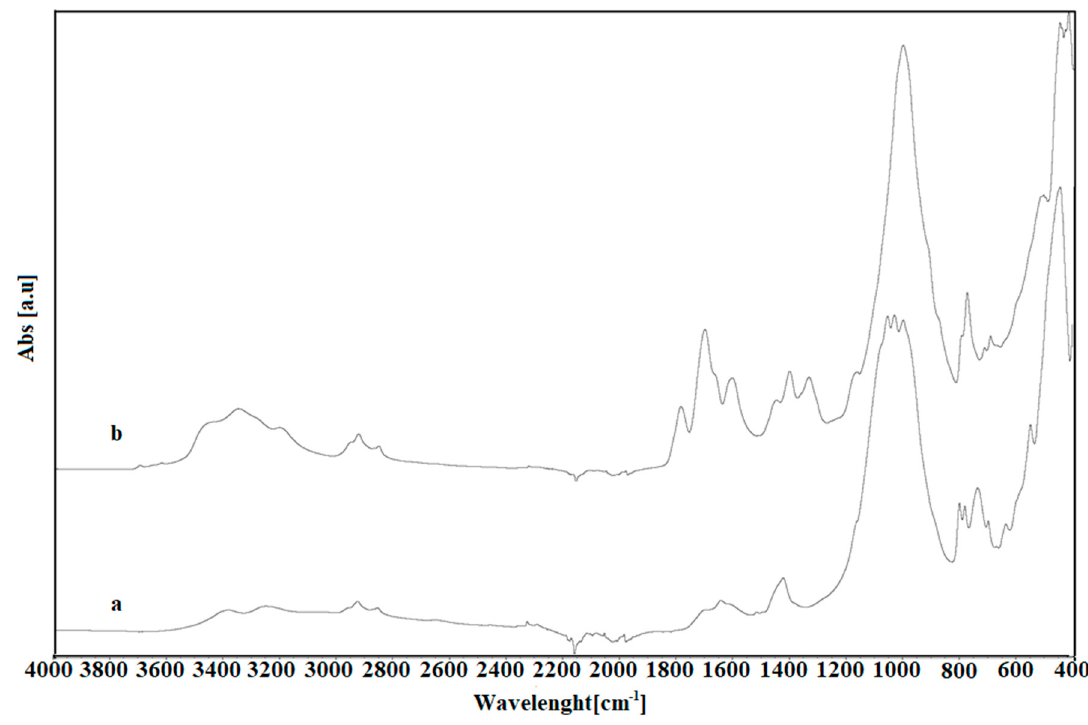
Figure 3. Attenuated total reflection Fourier transform infrared spectroscopy (ATR-FTIR). The spectrum generated in the range of 4000 to 400 cm − 1 is shown for the native biosolids-based catalyst ( a ) and a recycled catalyst that had been used in four catalytic reactions ( b ).